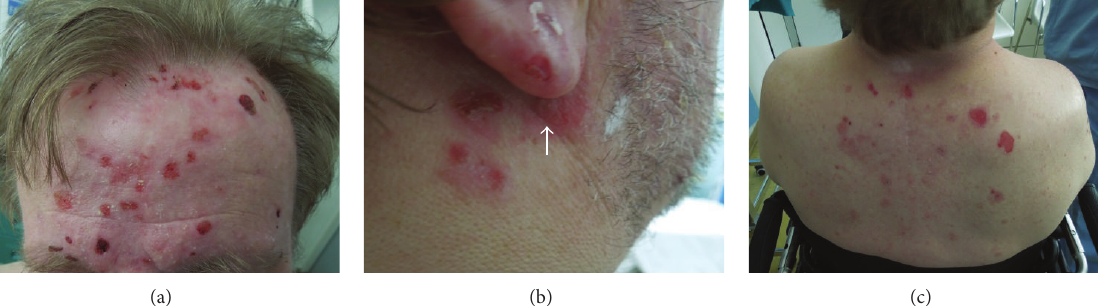
Figure 1: Several erosions (some of which with a peripheral epithelial collarette) and hematic and serous crusts on a slightly erythematous background on forehead (a), right periauricular region (b), and interscapular area (c); a flaccid blister (arrow) is visible under the right ear lobe (b).